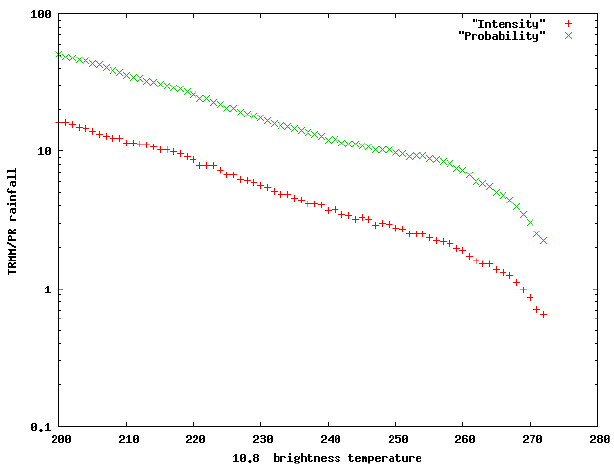
Figure 1.a. Empirical relationship between precipitation (rain rate and number of events) and 10.8 µm brightness temperature. The mean precipitation rate (red curve) is in mm/h and the mean number of rainfall events (green curve) is in percent. Both curves are plotted in logarithmic scale.